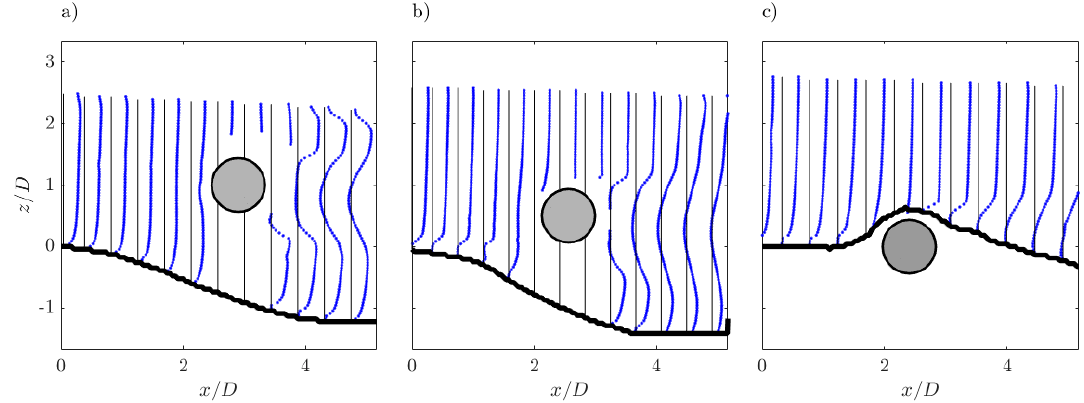
Figure 5. Dimensionless ensemble ‐ averaged velocity fields on a vertical plane in ( a ) Run 1, ( b ) Run 2 and ( c ) Run 3.